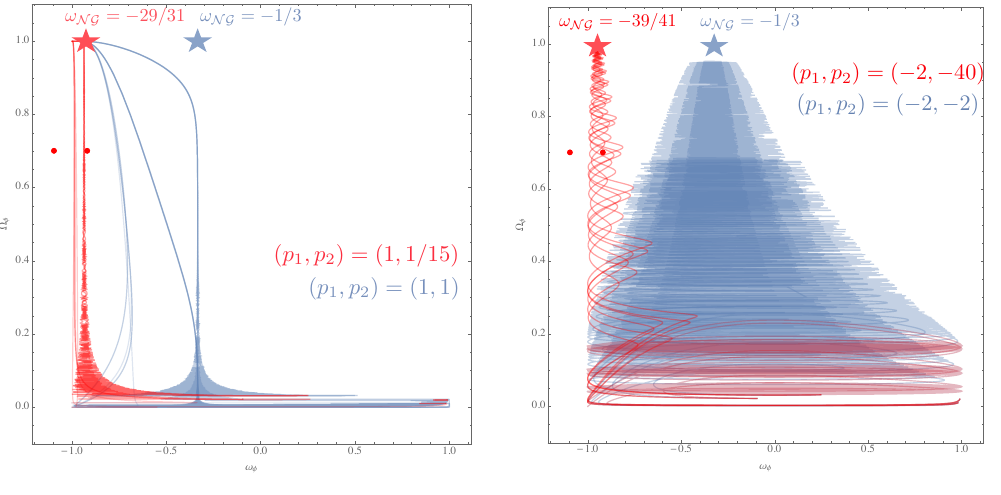
p 1 and 1 = (cid:0) (cid:30) 1